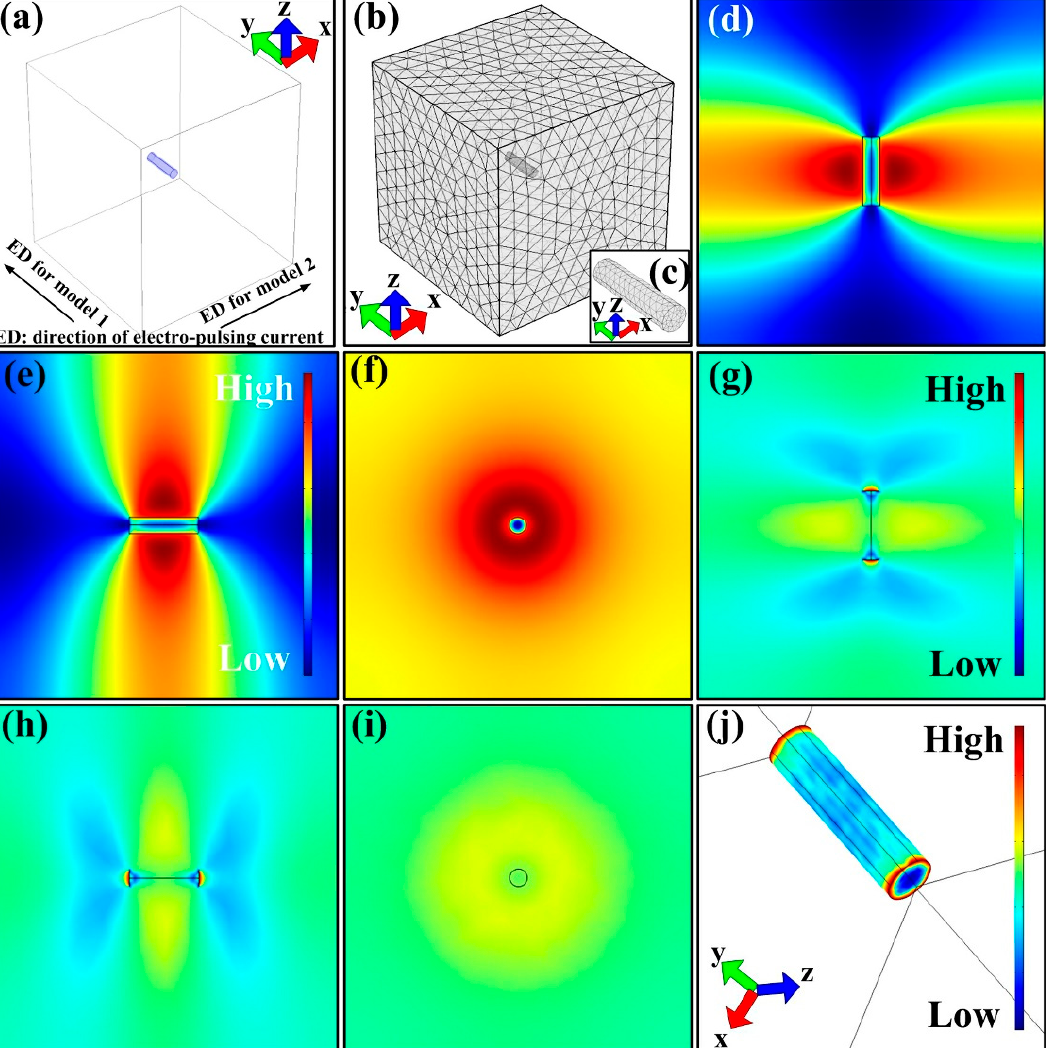
Figure 8. Simulation results of model 1: ( a ) Model construction, ED refers to electric current direction; ( b ) meshing of models; ( c ) an enlarged image of cylinder of dislocation in (b). ( d – f ) The distribution of temperature at XY, YZ, and XZ plane; ( g – i ) the distribution of current density at XY, YZ, and XZ plane; ( j ) thermal stress distribution.